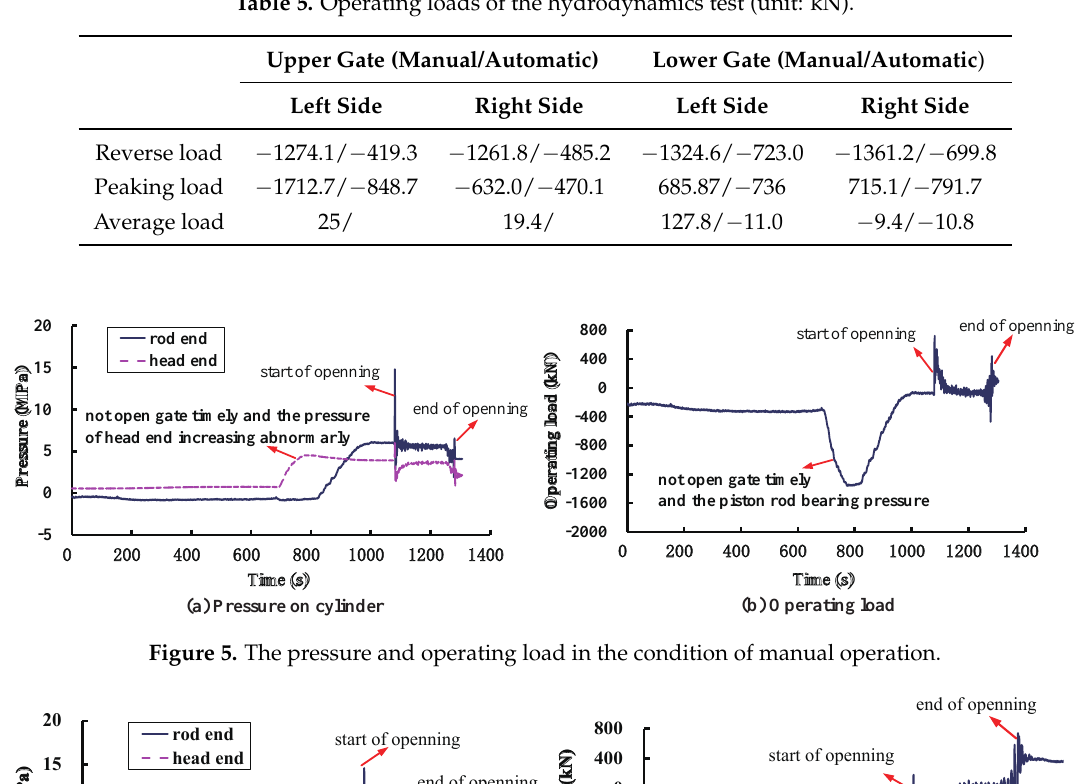
Table 5. Operating loads of the hydrodynamics test (unit: kN).